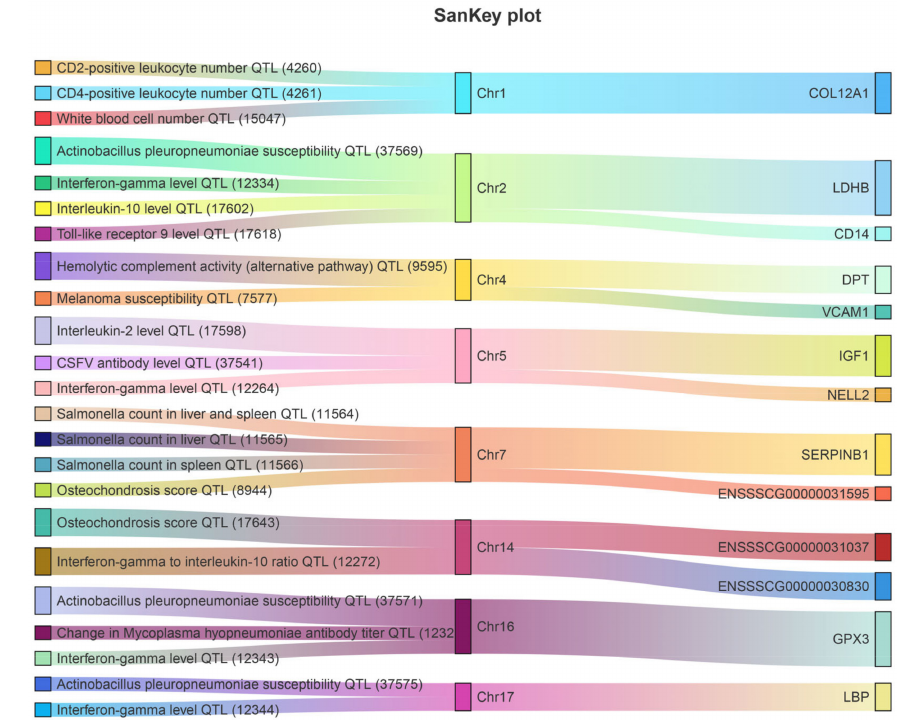
Figure 6. The intersection of 16 key genes with swine immunity and disease-related QTL data.